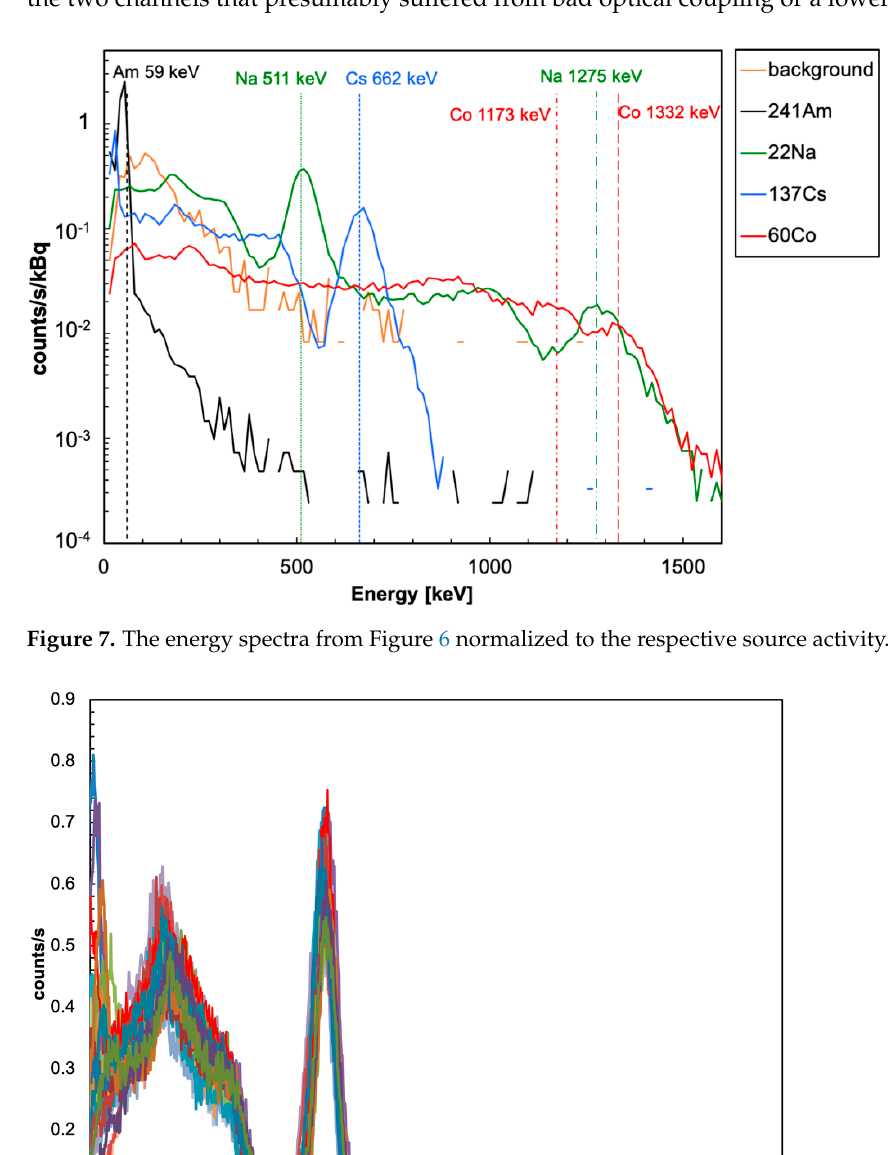
Figure 9. The 25 calibrated spectra in the configuration with the lead collimator.